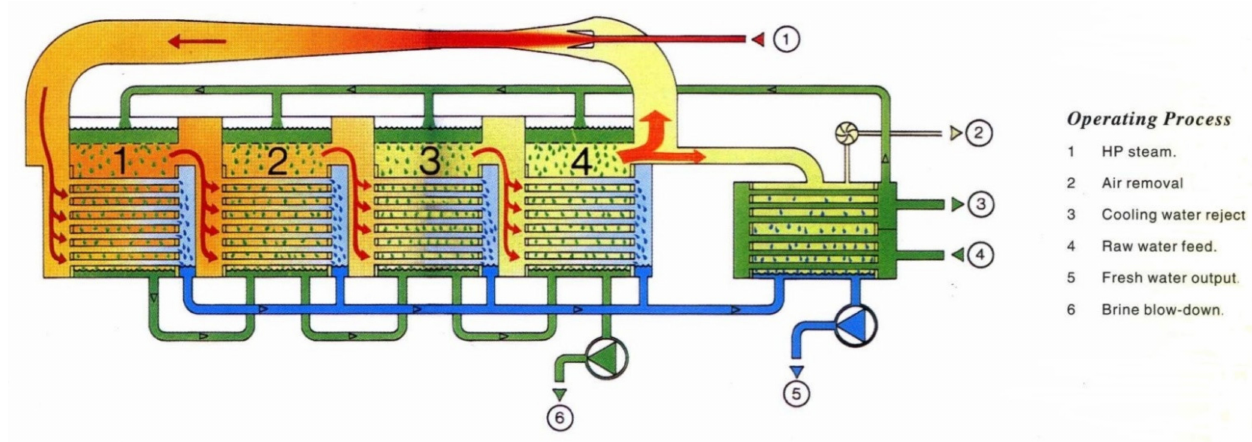
Figure 7. Schematic drawing of a multiple effect desalination (MED) plant. Vapour from the seawater then passes to the next stage, where it is condensed by further seawater spray. Four stages are shown in Figure 7, but in a large MED plant there could be up to twelve or so stages, or effects. As the seawater vaporises it loses incondensible gases, including oxygen. Thus, the evaporators are low in oxygen, but are not fully deaerated. Figure 8 shows the different potentials that stainless steel can adopt in seawater [54].